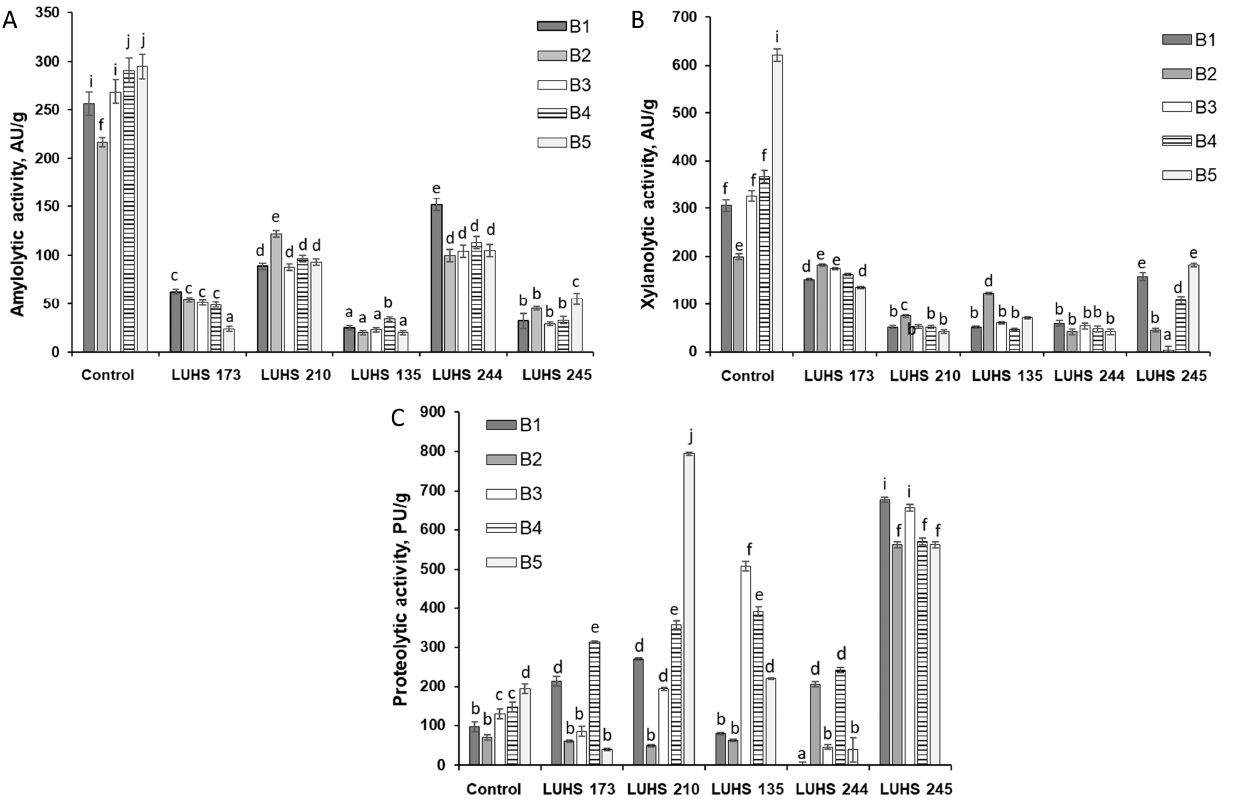
Figure 2. Changes in amylolytic ( A ), xylanolytic ( B ), and proteolytic ( C ) activities in barley whole- meal samples (BWP1-BWP5) during fermentation with LAB strains (AU—amylolytic and xylanolytic enzyme activity units; PU—proteolytic enzyme activity units; Levilactobacillus brevis LUHS173, Lacticaseibacillus casei LUHS210, Lactiplantibacillus plantarum LUHS135, Lacticaseibacillus paracasei LUHS244, and Liquorilactobacillus uvarum LUHS245). a–j Mean values denoted with different letters indicate significantly different values between the columns ( p ≤ 0.05).